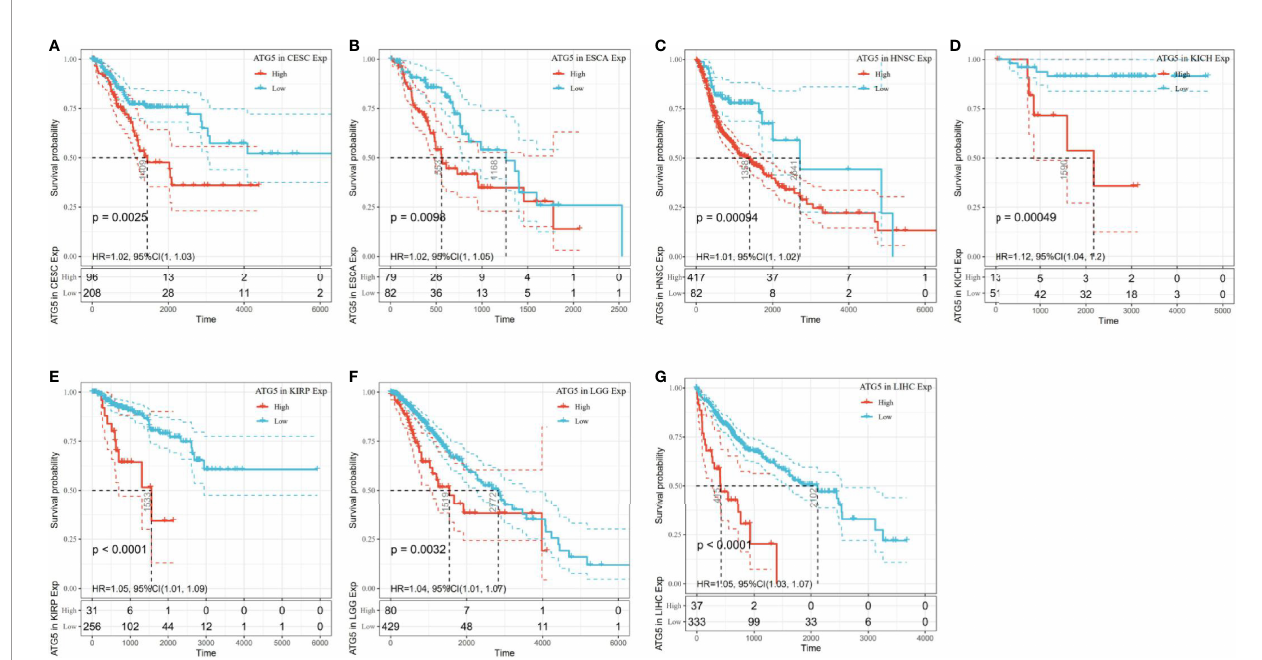
FIGURE 3 | Kaplan – Meier OS curves of ATG5 expression in the seven most signi fi cantly associated tumors. (A) KM plot of high and low ATG5 expression in CESC patients. (B) KM curves of high and low ATG5 expression in ESCA patients. (C) KM plot of high and low ATG5 expression in HNSC patients. (D) KM curves of high and low ATG5 expression in KICH patients. (E) KM curves of high and low ATG5 expression in KIRP patients. (F) KM curves of high and low ATG5 expression in LGG patients. (G) KM curves of high and low ATG5 expression in LIHC